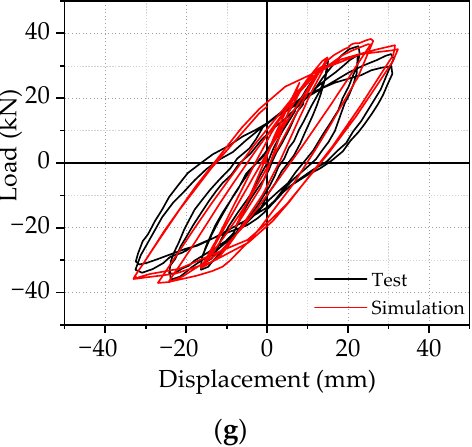
Figure 5. Comparison of hysteresis curves of ( a ) BCJ0; ( b ) BCJ1; ( c ) BCJ2; ( d ) BCJ3; ( e ) BCJ4; ( f ) BCJ5; ( g ) BCJ6.